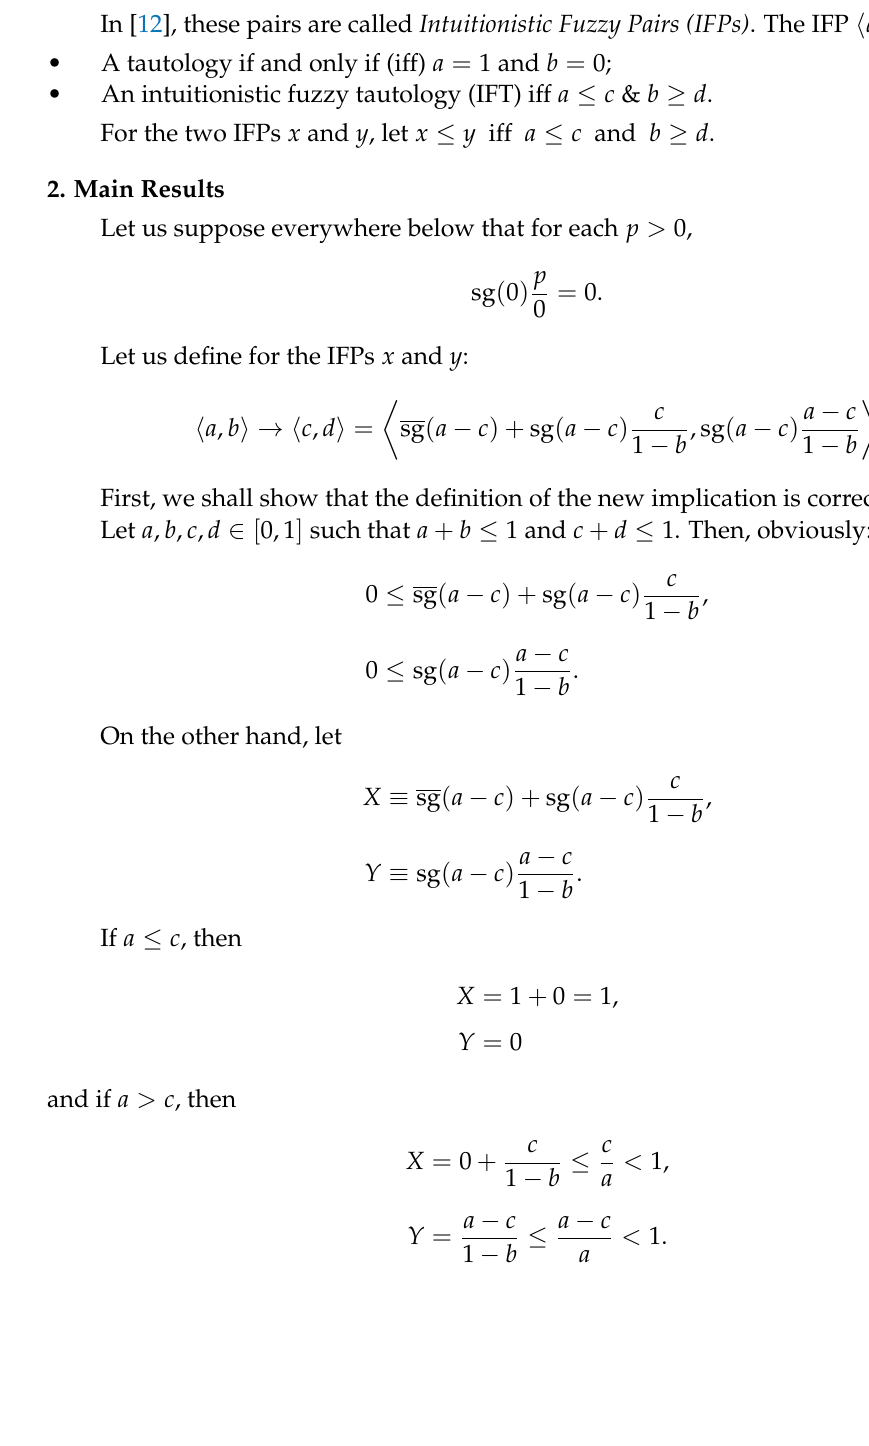
Figure 1. The geometrical interpretations of elements x ∈ E